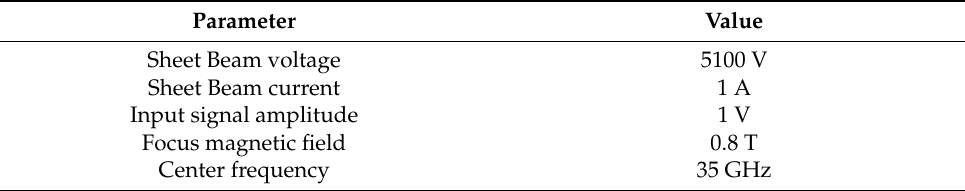
Table 2. Optimized electrical parameters for the